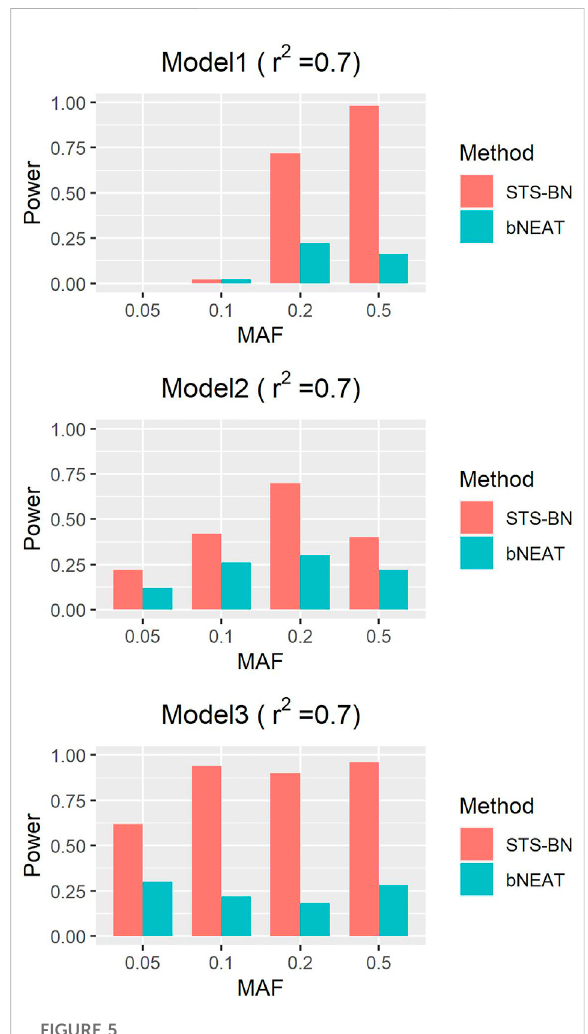
FIGURE 5 Performance comparison of STS-BN and bNEAT. The input orders of markers are randomly disturbed and r 2 =